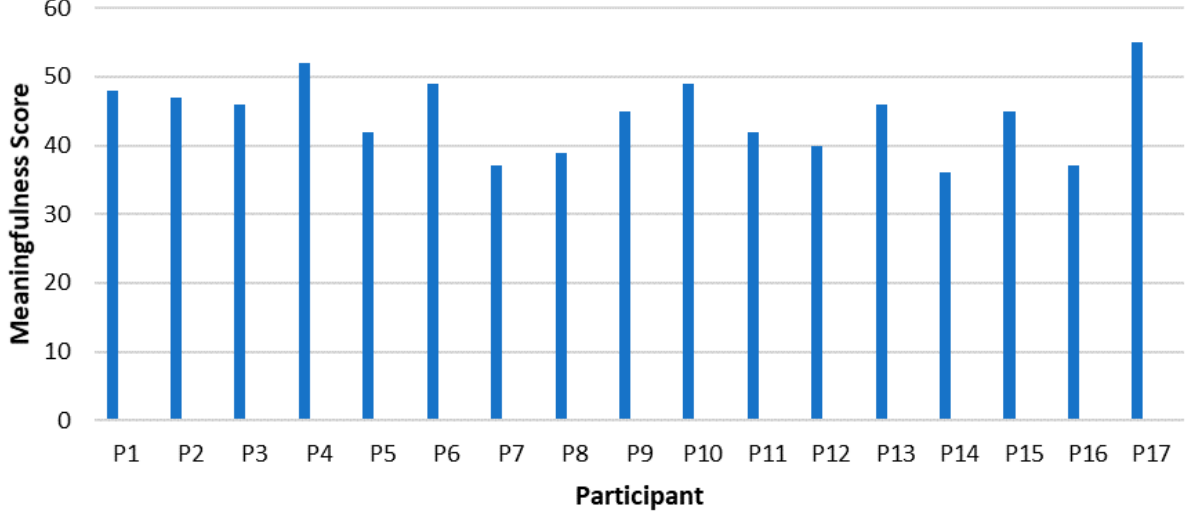
Figure 3. Meaningfulness in Managers.